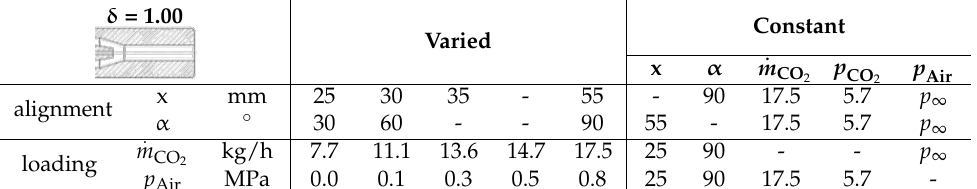
Table 1. Varied nozzle alignments and nozzle loadings using a cylindrical shaped nozzle outlet. δ = 1.00